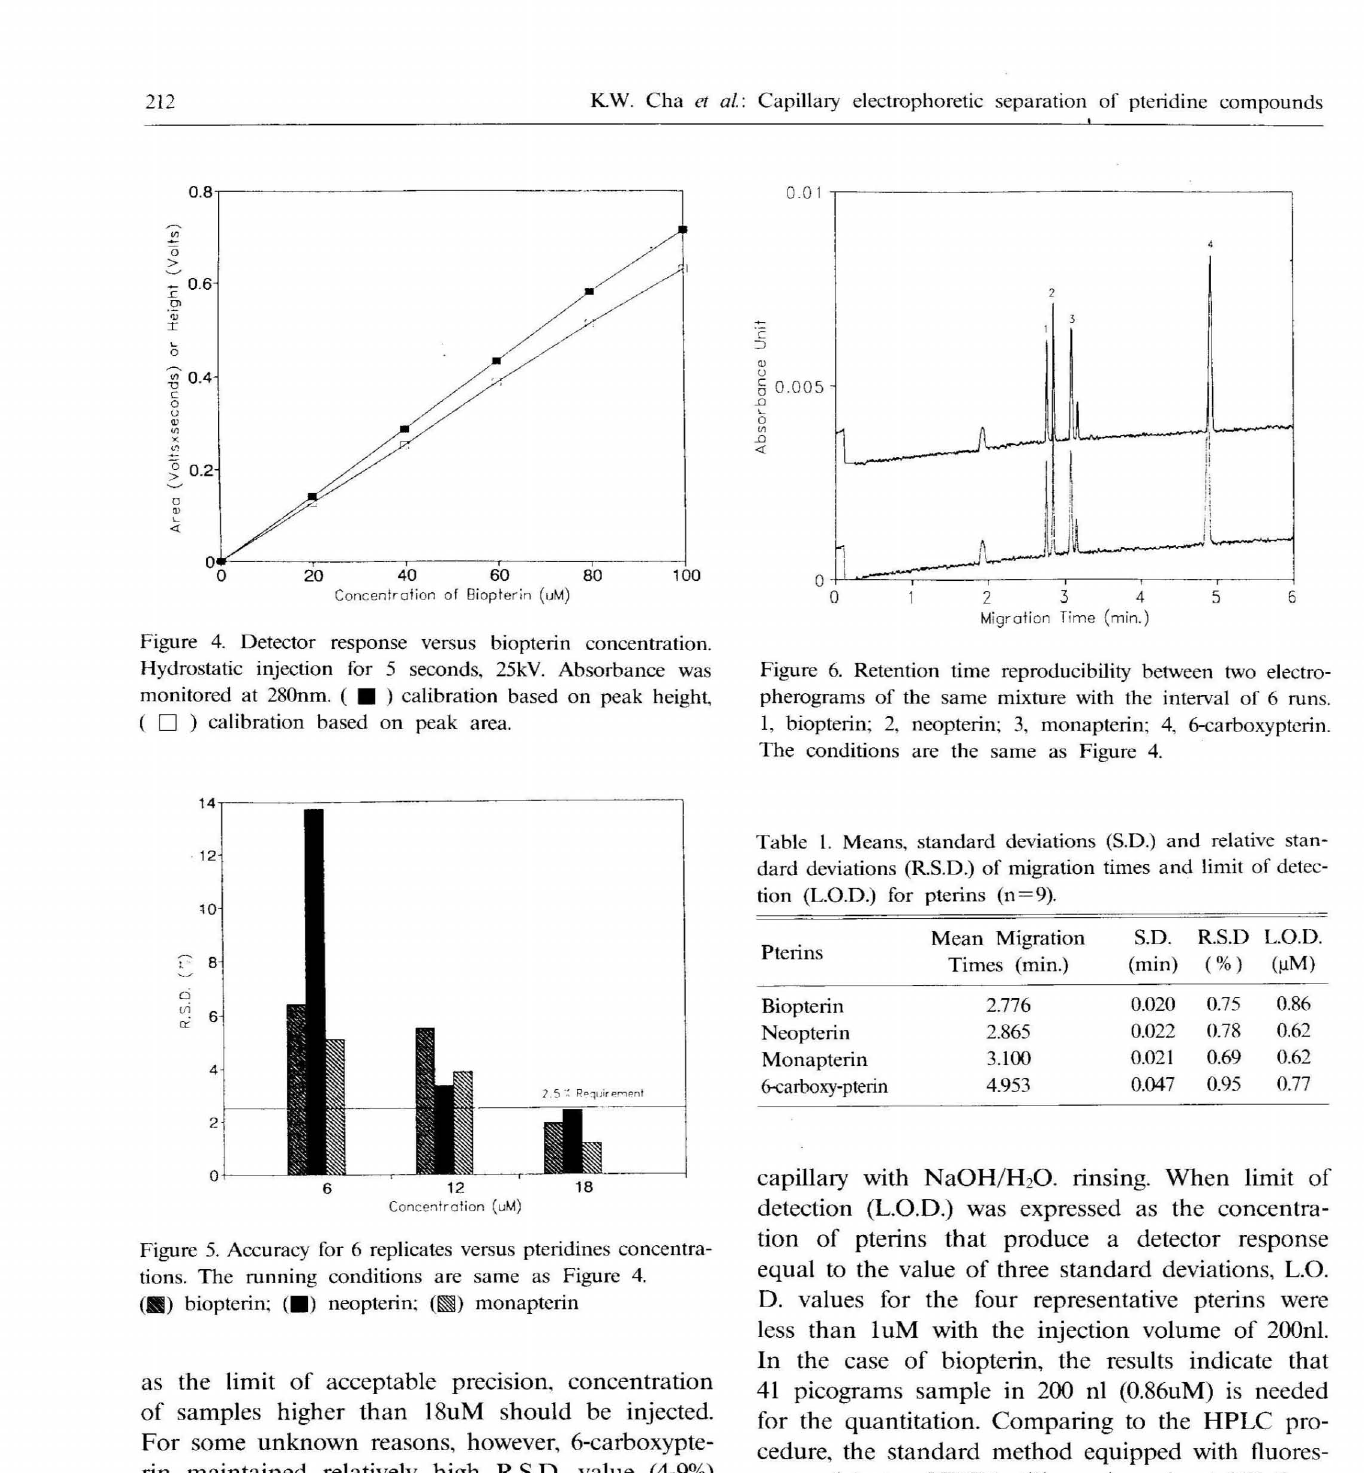
capillary with NaOH/H20. rinsing. When limit